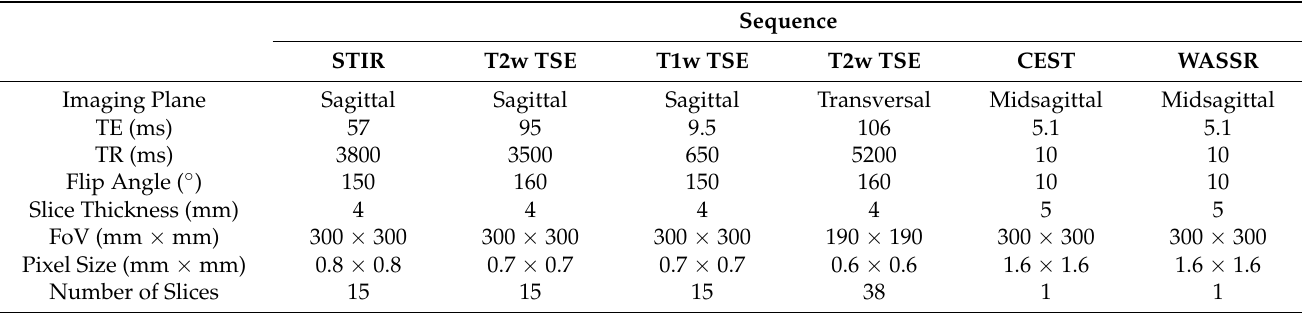
Table 2. Detailed Magnetic Resonance Imaging (MRI) Sequence